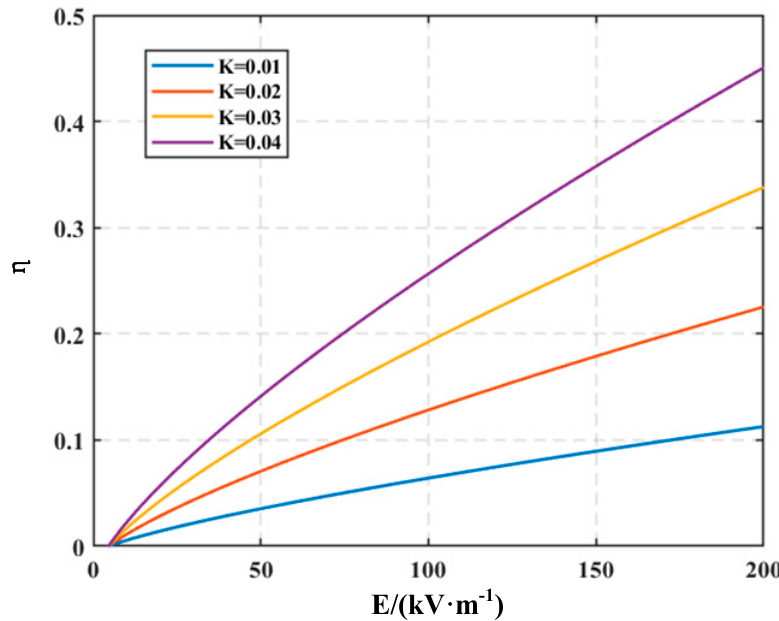
Figure 9. Variation trend of the arc establishment rate and arc establishment coefficient.